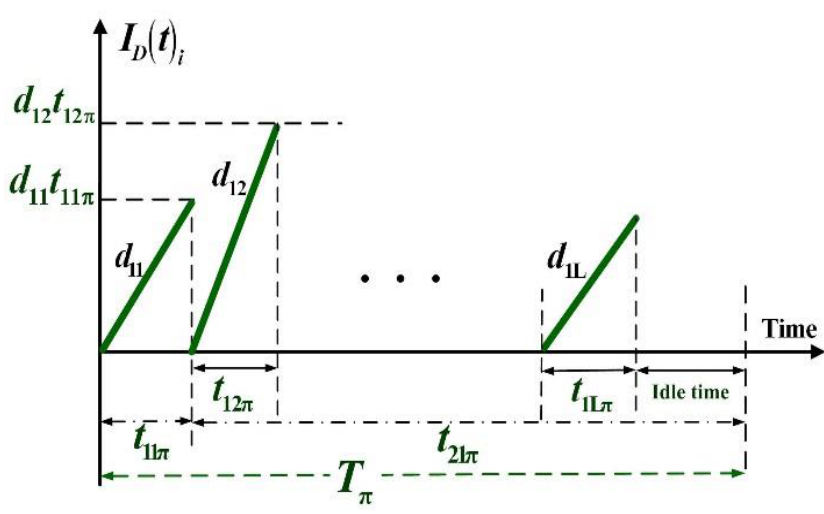
Figure 2. Inventory status of scrapped items of product i in the proposed